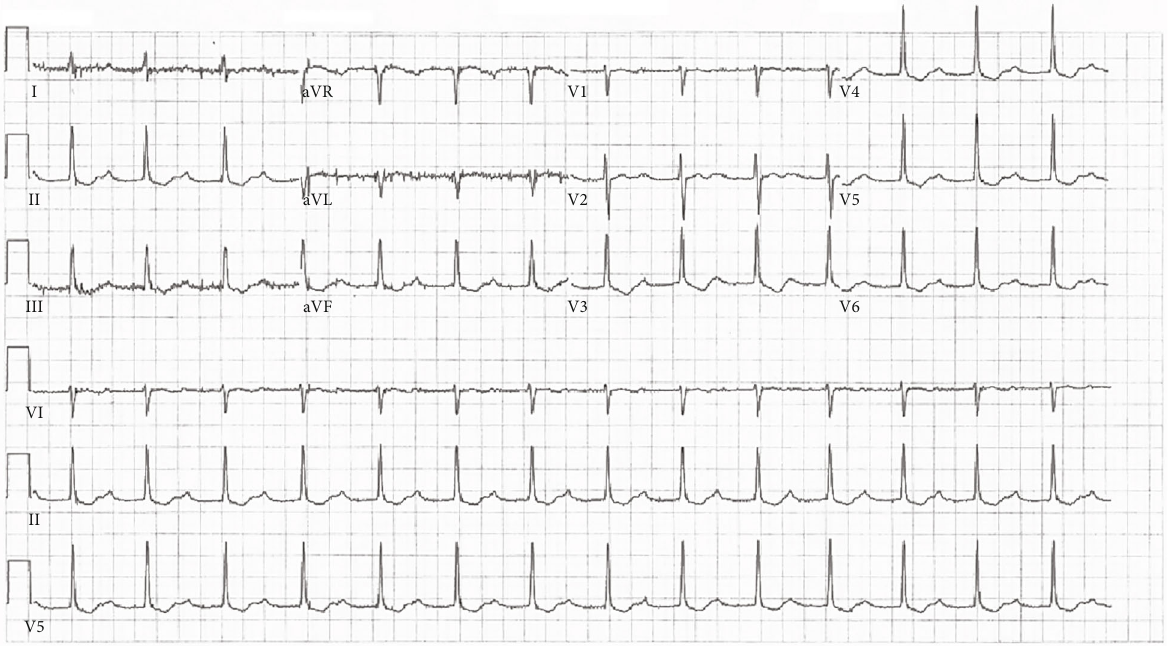
Figure 1: An electrocardiogram showing fi rst-degree atrioventricular heart block two days following ingestion of a candlenut. Also noted is a characteristic scooping of the ST segment known as the digitalis e ff ect .